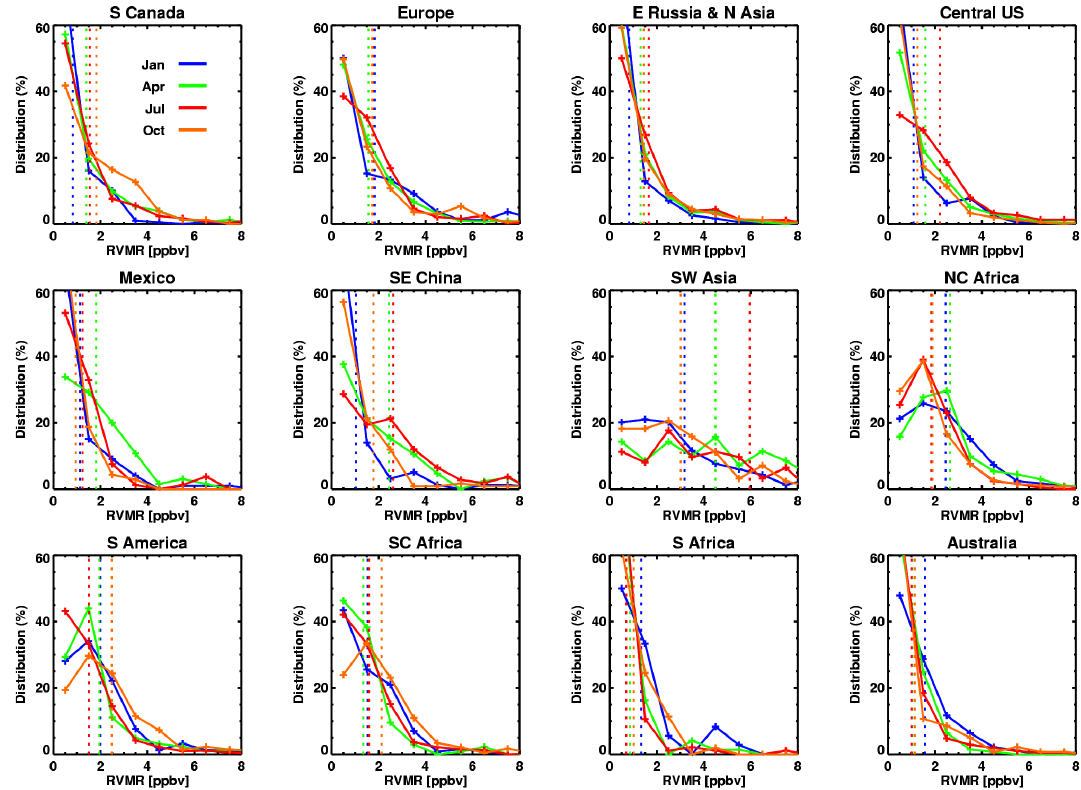
Fig. 22. Density distribution of the TES RVMRs for each region and month; histogram bin size is 1.0; dashed lines indicate mean values for the corresponding